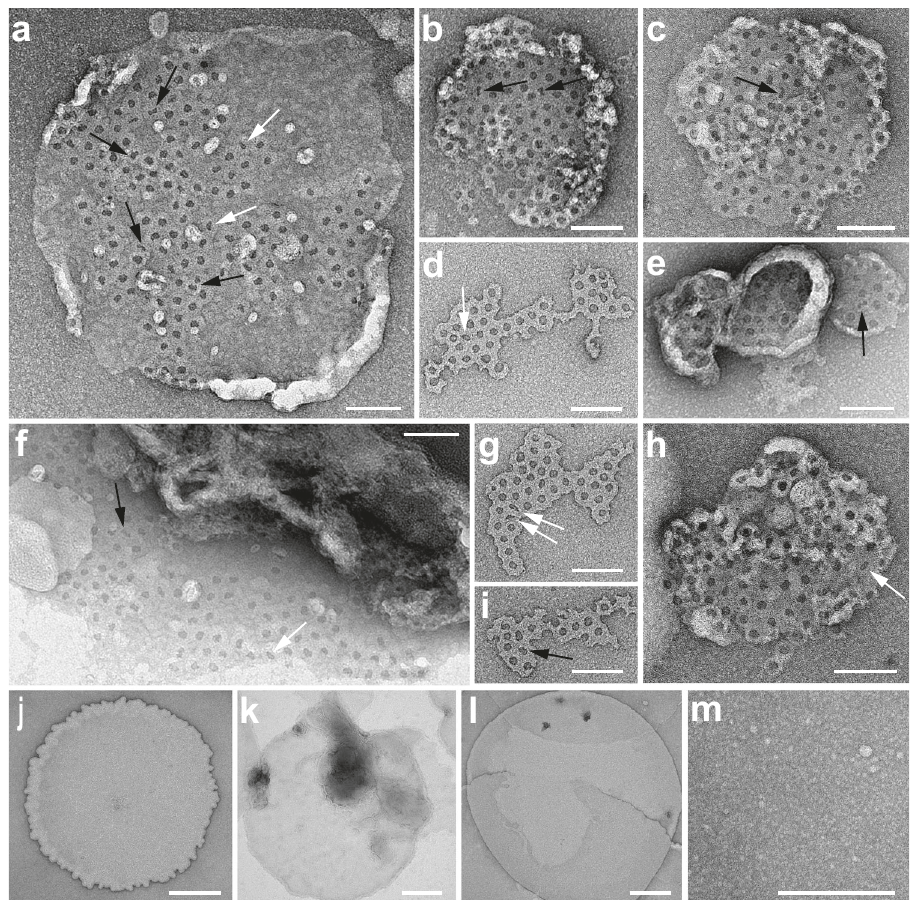
Fig. 3 Transmission electron microscopy (TEM) of negative stained mGSDMA3 Nterm oligomers inserted into liposomes made from E. coli polar lipid extract. a – i TEM images of liposomes after incubation with mGSDMA3 in the presence of TEV. Upon adsorption onto TEM grids the liposomes fused into membrane patches that spread out over the carbon fi lm. Most mGSDMA3 Nterm oligomers inserted into the lipid membranes appear ring-shaped but arc- shaped (black arrows) and slits-shaped (white arrows) oligomers are observed as well. Suspended liposomes made from E. coli polar lipid extract were incubated overnight at 37 °C with 7 μ M mGSDMA3 and 1.5 µ M TEV. j – l TEM images showing large vesicles fused on the carbon fi lm from empty E. coli polar lipid liposomes ( j ), from liposomes incubated with mGSDMA3 (7 μ M) ( k ), and from liposomes incubated with TEV (1.5 μ M) ( l ). m The mixture of mGSDMA3 and TEV incubated in the absence of liposomes exhibits a granular appearance. None of the samples ( j – m ) showed arc ‐ , slit ‐ , or ring ‐ shaped oligomers as observed for mGSDMA3 Nterm incubated with liposomes. All samples ( a – m ) were incubated overnight at 37 °C, adsorbed to glow-discharged carbon coated grids, negatively stained with uranyl acetate and imaged at 120 kV (Methods). Scale bars, 100 nm ( a – i ) and 200 nm ( j – m